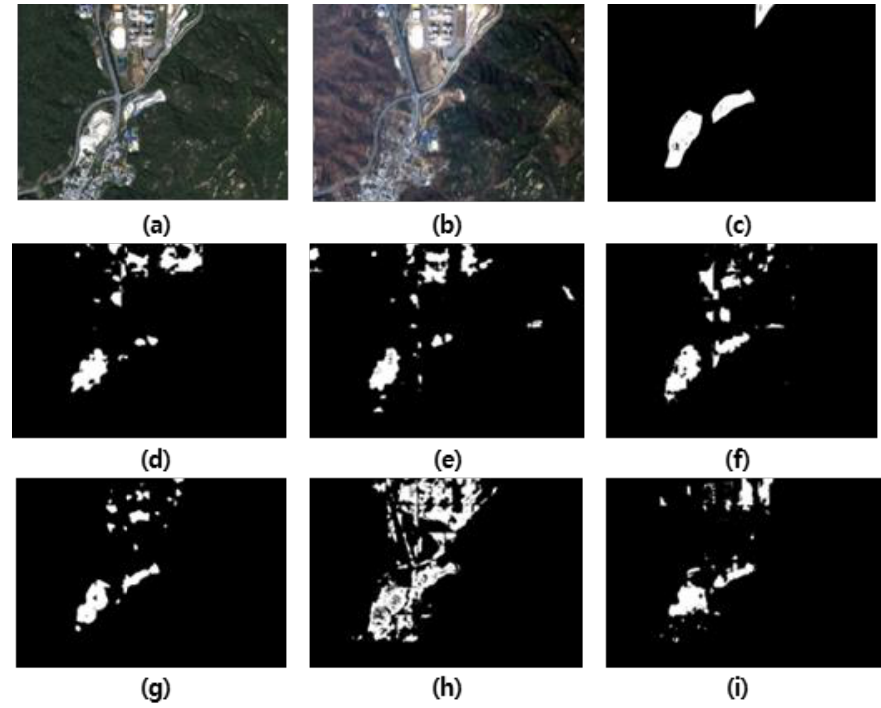
Figure 16. Changed detection maps of the proposed and conventional algorithms for “Test area 3”: ( a ) Image P; ( b ) Image C; ( c ) Ground truth; ( d ) DI + UNet; ( e ) DI + ATTUNet; ( f ) JF + UNet; ( g ) JF + ATTUNet; ( h ) Modified-UNet++; ( i ) Proposed bilateral U-Net.